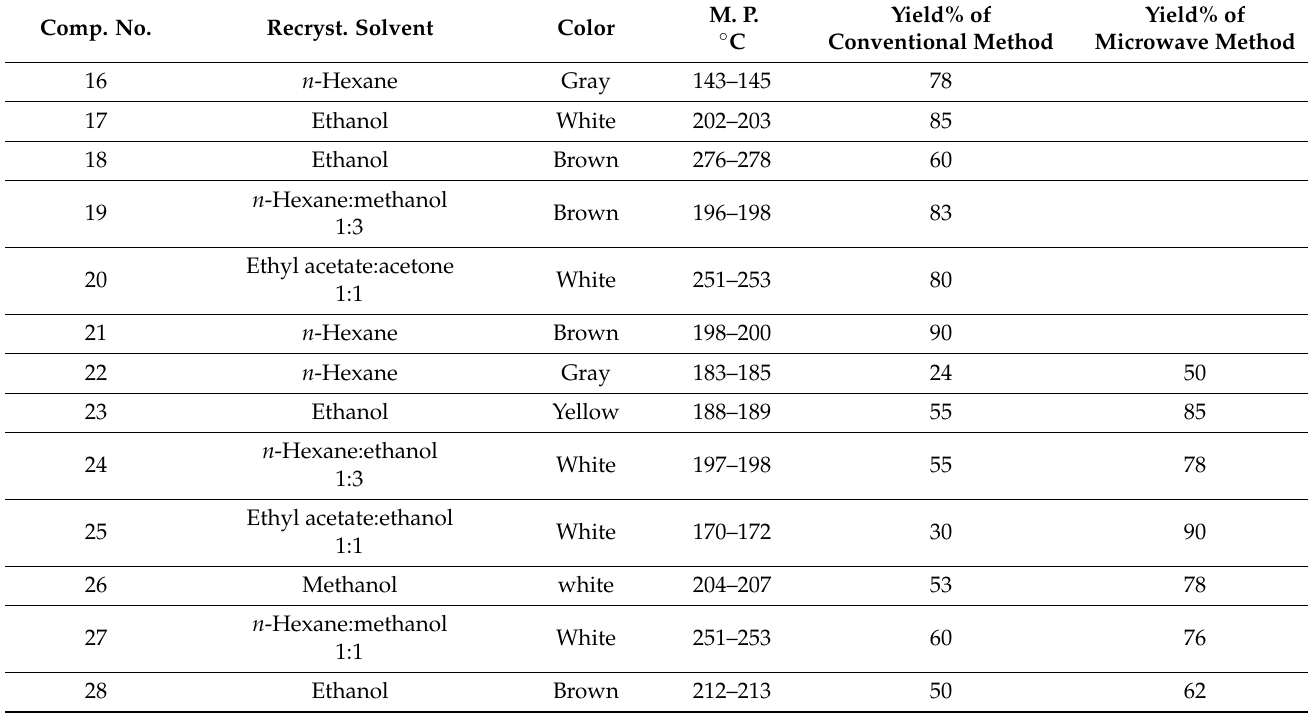
Table 1. Melting points, colours, solvents for recrystallization, and yields of the compounds 16 – 28 . Comp. No. Recryst.